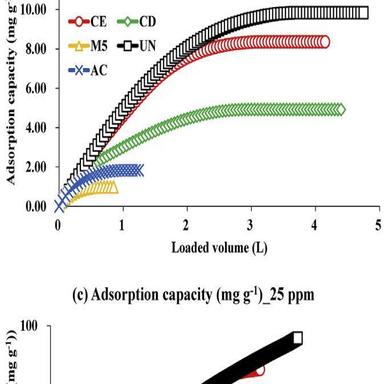
Adsorption capacities of the tested adsorbents toward high FA concentrations (5–25 ppm) (ambient temperature and 2 mg adsorbents).